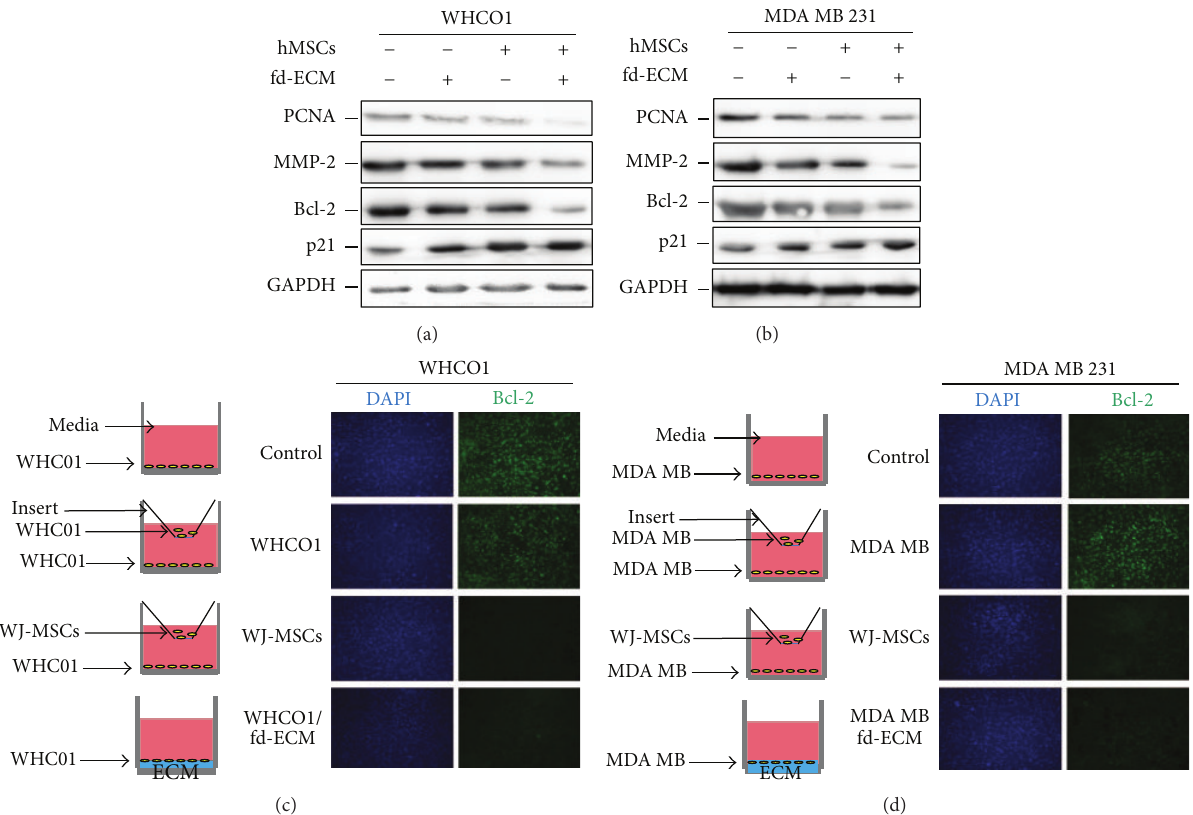
Figure 3: MSCs and the fd-ECM synergistically downregulate WHCO1 and MDA MB 231 gene expression. (a) Western blot analysis of lysates from WHCO1 cells cocultured with MSCs, cultured on an fd-ECM, or in combination, for 48 hrs showing expression of PCNA, Bcl-2, MMP- 2, and p21. (b) Western blot analysis of lysates from MDA MB 231 cells cocultured with MSCs, cultured on an fd-ECM, or in combination, for 48 hrs showing expression of the same genes as in (a). (c) Immunofluorescence staining for Bcl-2 in WHCO1 cells after coculture with WHCO1 cells (second panel) and WJ-MSCs (third panel) and also cultured on fd-ECM (fourth panel). (d) Immunofluorescence staining for Bcl-2 in MDA MB 231 cells after coculture with MDA MB 231 cells (second panel) and WJ-MSCs (third panel) and also cultured on fd-ECM (fourth